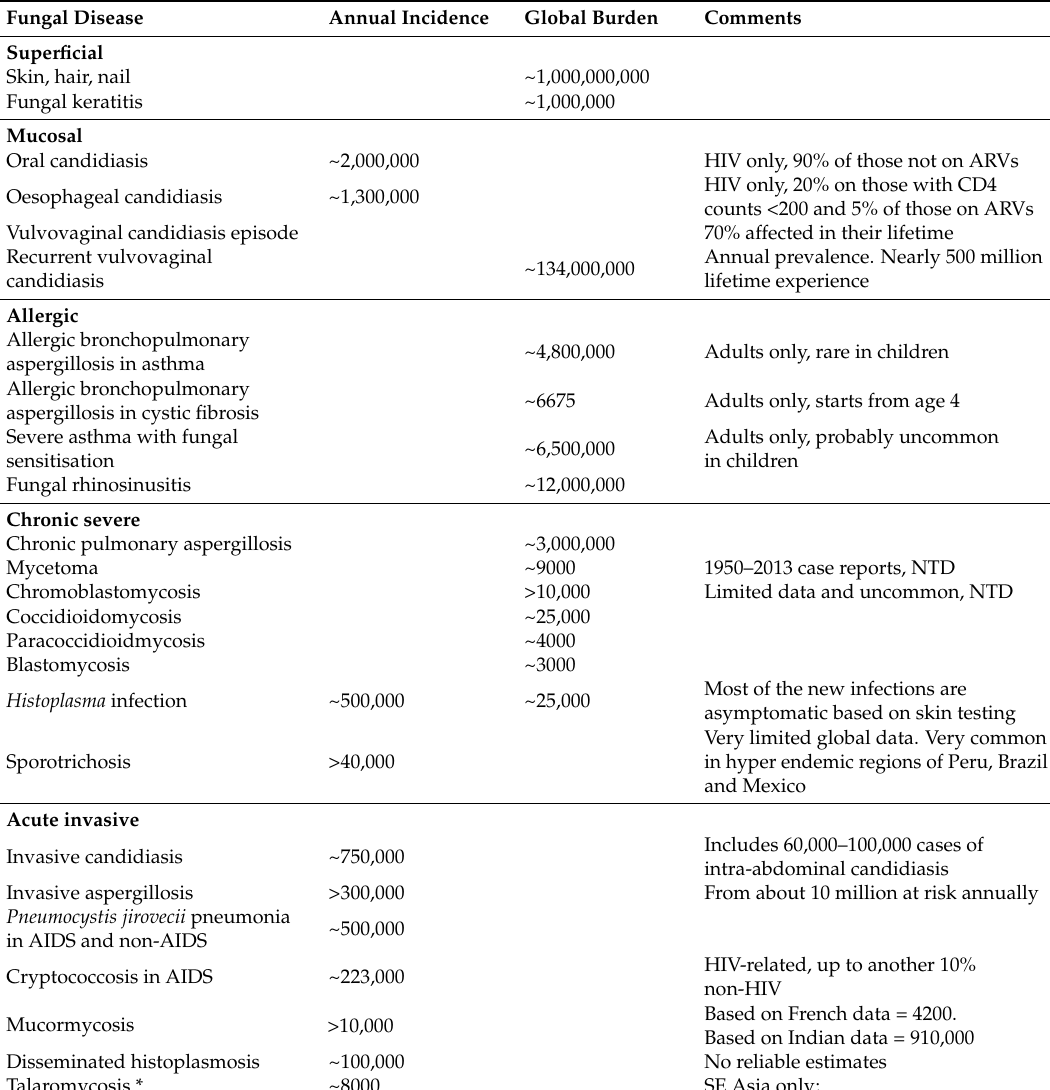
Table 1. Burden of fungal